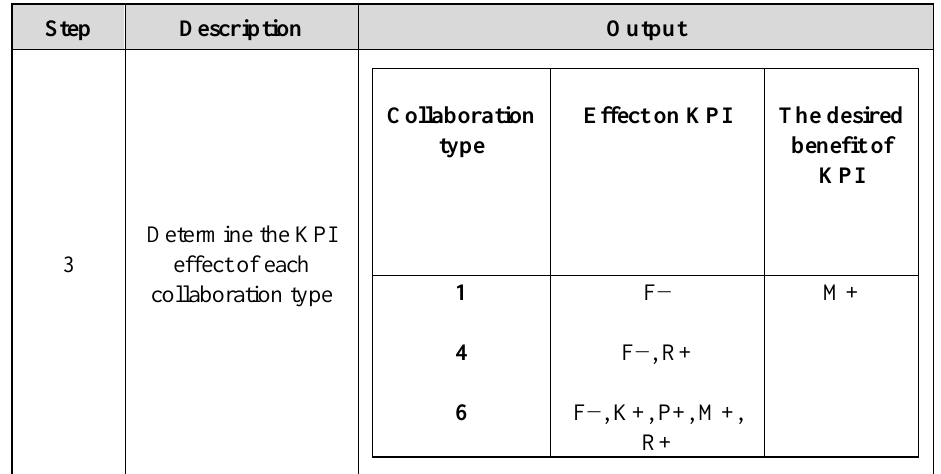
Table 9. Step 3/5 of detecting collaboration partner